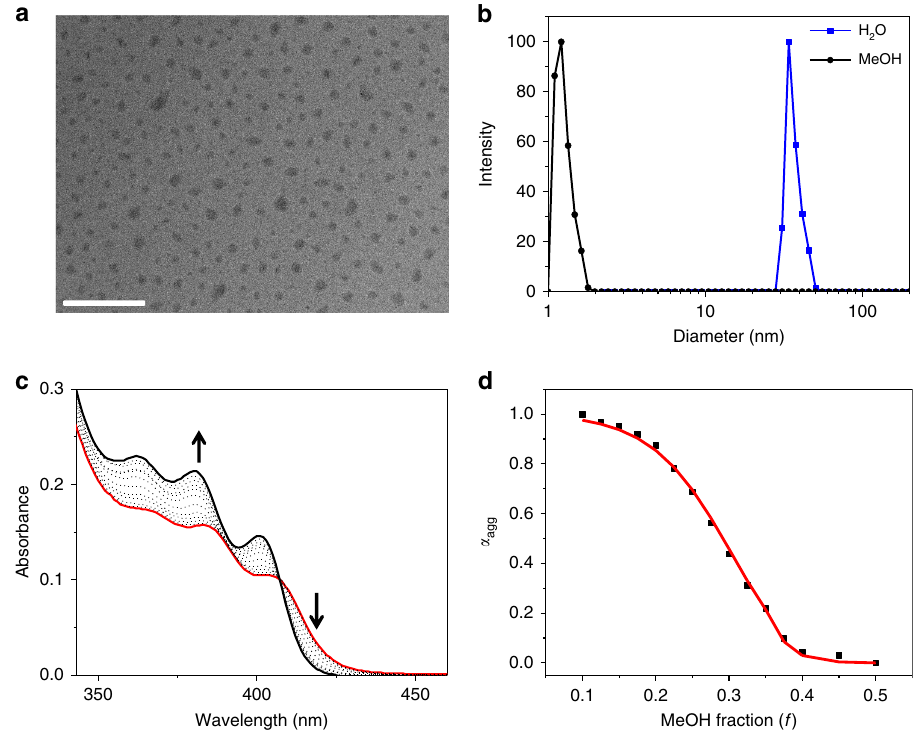
Fig. 2 Characterization of the self-assembled system from 3 . a Transmission electron microscopic image recorded on a copper grid by drop-casting a 5.00 × 10 − 5 M solution of 3 in water. Scale bar: 500 nm. b Hydrodynamic size distribution of a 5.00 × 10 − 5 M solution of 3 measured by dynamic light scattering at 298 K. c Solvent-dependent ultraviolet – visible absorption spectra of 3 [5.00 × 10 − 5 M in water/MeOH (from 90:10 to 50:50, v / v )]. The arrows indicate the spectral change upon increasing the MeOH fraction. d Degree of aggregation ( α agg ) as a function of MeOH volume fraction ( f ) monitored at 420 nm. The red line denotes the mathematical fi tting of the curve, according to the solvent-dependent equilibrium model (see Eqs. (1) and (2) in “ Methods ” ). Accordingly, Δ G ( f = 0.1) [denoting the Gibbs free energy gain upon monomer association in water/methanol (90:10, v / v )] is determined to be − 32.4 kJ mol −